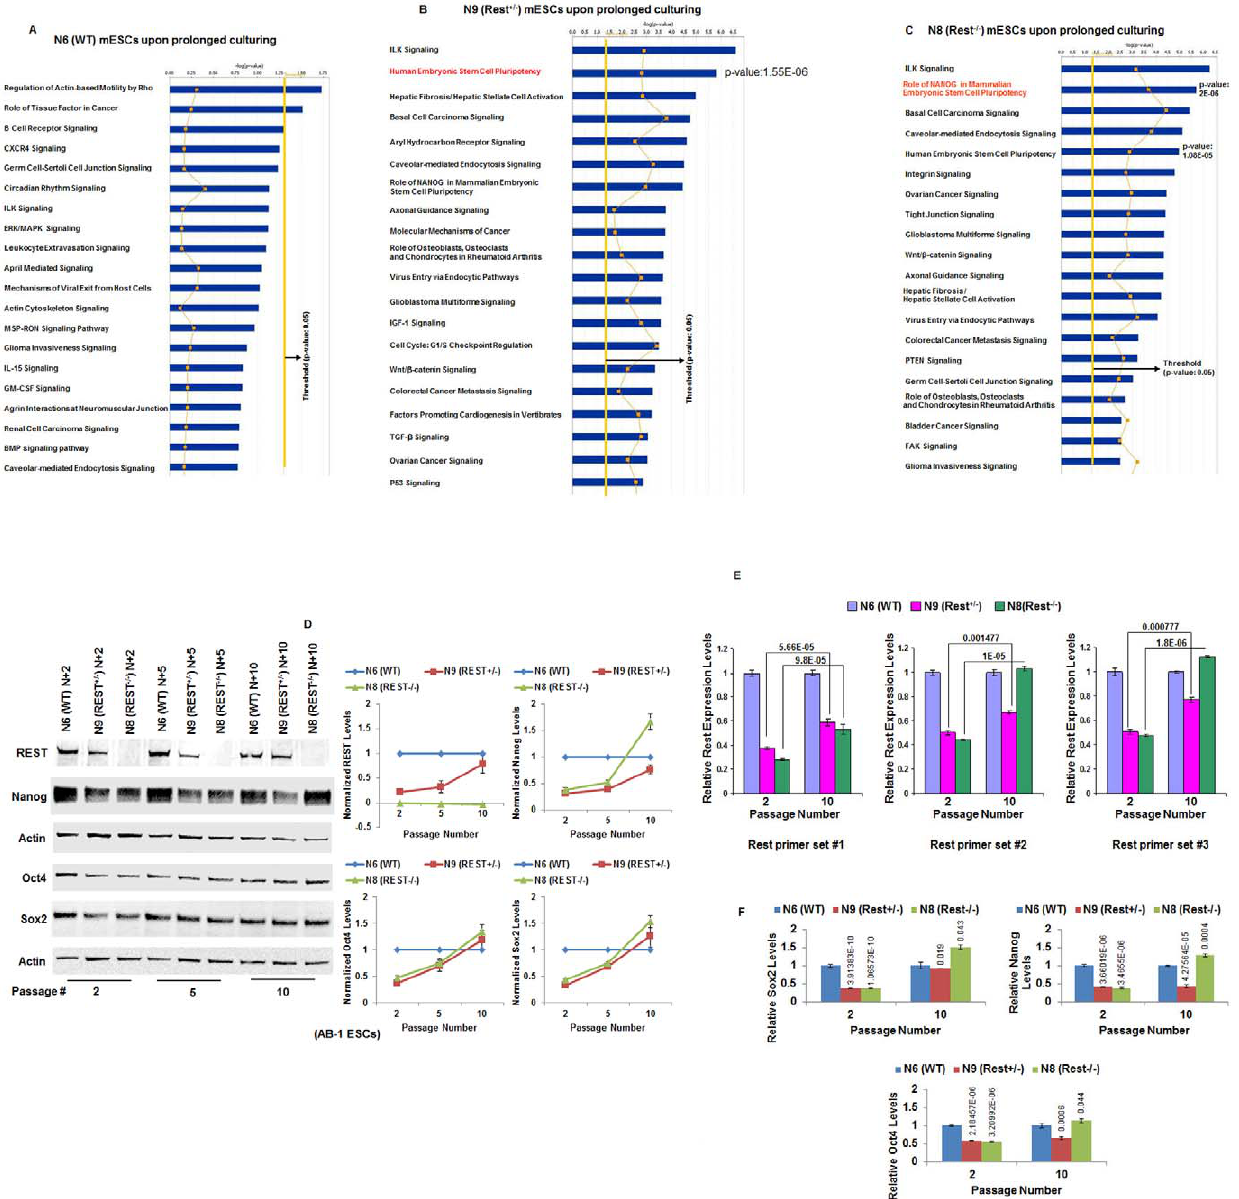
Figure 2. Restoration of the impaired self-renewal and pluripotency of Rest + / 2 and Rest 2 / 2 AB-1 ESCs upon prolonged culture correlates, at least in part, with increased ESC pluripotency pathways. (A, B and C) Ingenuity pathway analysis comparing canonical pathways in N6 (WT) cells during the transition between passage 2 and passage 10. While the wild-type cells did not have any significant changes in cellular pathways (except three, A), several pathways including the human embryonic stem cell pluripotency in Rest + / 2 (B) and Nanog embryonic stem cell pluripotency pathway changed in Rest 2 / 2 cells (C). (D, E and F) Validation of the results of genome-wide analyses in Rest + / 2 and Rest 2 / 2 ESCs. (D) Western blotting assays to measure REST protein levels (left panel: Western blot, right panels: quantification of western blot) and the core pluripotency factors Oct4, Sox2, and Nanog (left panel: Representative Western blot, right panels: quantification of three western blots for Rest + / 2 and four western blots for Rest 2 / 2 ) in cells cultured for 2, 5, and 10 passages. Actin was used as a loading control. Error bars are standard error of means. Quantification of western blots was performed using Odyssey V3.0 software and was plotted after normalization against actin. REST protein levels were elevated in Rest + / 2 cells over passages but, it remained unchanged in the wild-type and Rest 2 / 2 cells. Whereas the wild-type cells maintained high levels of the core self-renewal factors Oct4, Sox2, and Nanog throughout the passages, their levels were significantly lower during the early passages of Rest + / 2 and Rest 2 / 2 cells and increased with passage. Nanog levels increased the most in Rest 2 / 2 cells. (E) Relative expression levels of Rest in N9 (Rest + / 2 ) and N8 (Rest 2 / 2 ) cells (confirmed with three independent primer sets) are shown after normalization with N6 (WT) cells grown for equivalent passage. Passage numbers are shown on the x-axis. p-values are shown over the bars. Gapdh was used as control. Error bars are standard error of means (n=3). (F) Relative expression levels of pluripotency factors (Nanog, Oct4 and Sox2) in N9 (Rest + / 2 ) and N8 (Rest 2 / 2 ) cells are shown after normalization with N6 (WT) cells grown for equivalent passages. Passage numbers are shown on the x-axis. The p- values are shown over the bars. Gapdh was used as control. Error bars are standard error of means (n=3).